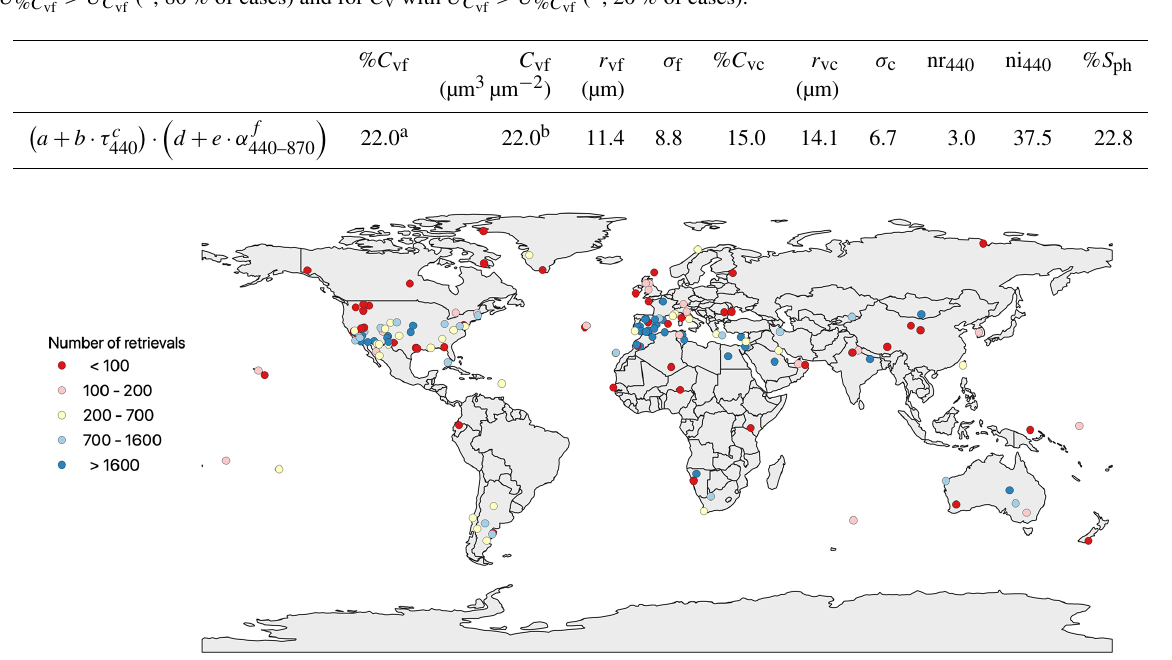
Table 5. Uncertainties (in percent) for each retrieved aerosol microphysical property model (as for Table 4) but after selecting sites for % C v > U C with U % C ( a ; 80% of cases) and for C v with U C vf vf